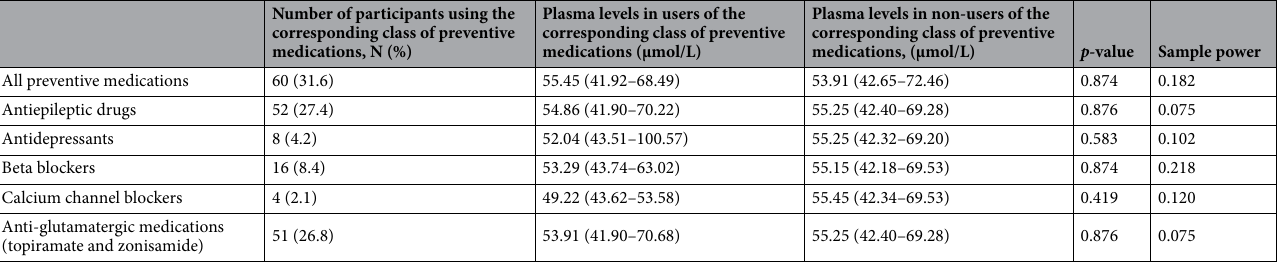
Plasma levels in users of the corresponding class of preventive medications (μmol/L)